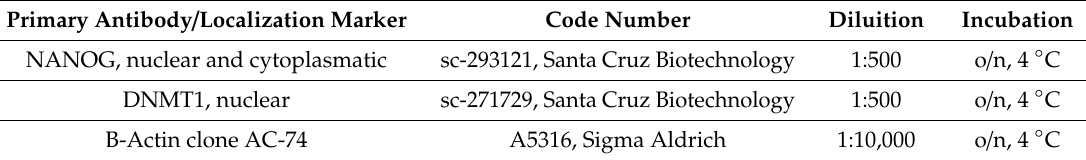
Table 1. Primary antibodies